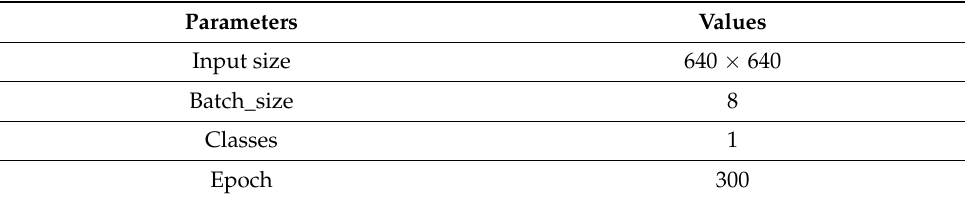
Table 2. Grape cluster detection parameters based on